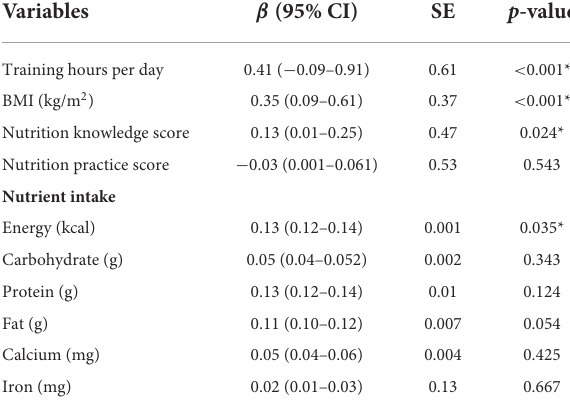
TABLE 6 Linear regression analysis of anthropometric measurement, nutrition knowledge, practice, and nutrient intake with strength performance among Taekwondo players ( n =